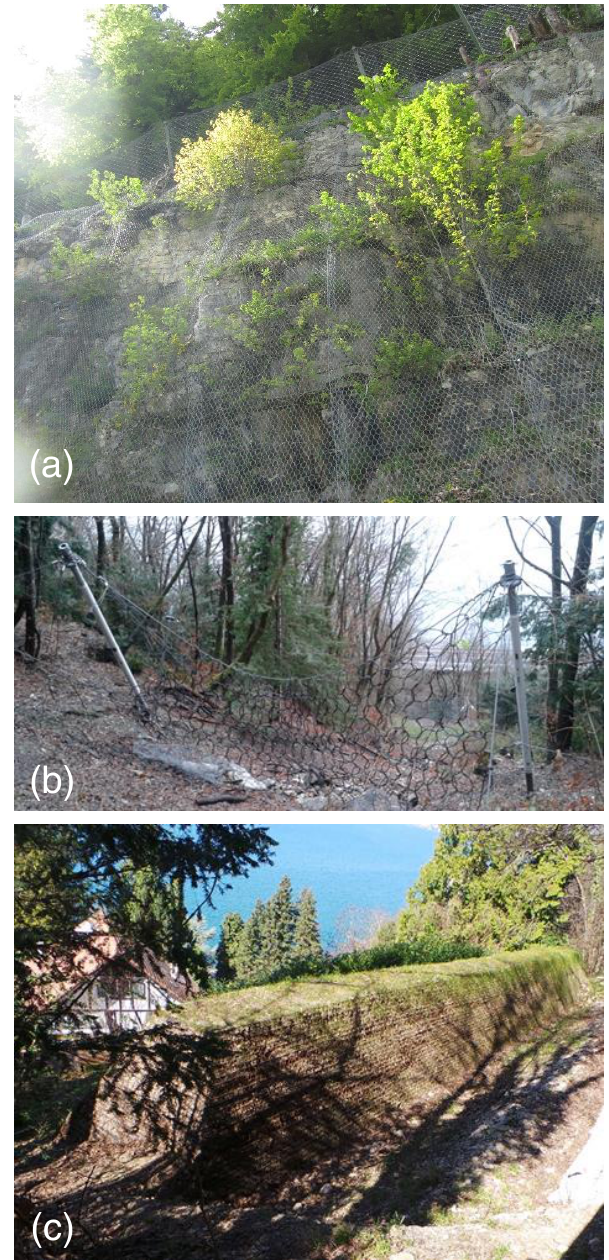
Fig. 2. Protection measures installed on the slopes above the city of Montreux (Switzerland). Above: barrier fences and cable nets Figure 2. Examples of protection measures installed on the slopes on the cliff overhanging the Cantonal Road near the town of Vallorbe. Centre: barrier fence (Source: Grisanti and Prina Howald, 5 of the canton of Vaud. (a) Barrier fences and cable nets on the cliff 2015). Below: earth dam (Source: Privat and Prina Howald, 2014). overhanging the Cantonal Road near the town of Vallorbe. (b) Bar- rier fence (source: Grisanti and Prina Howald, 2015) and (c) earth dam (source: Privat and Prina Howald, 2014) on the slopes above the city of